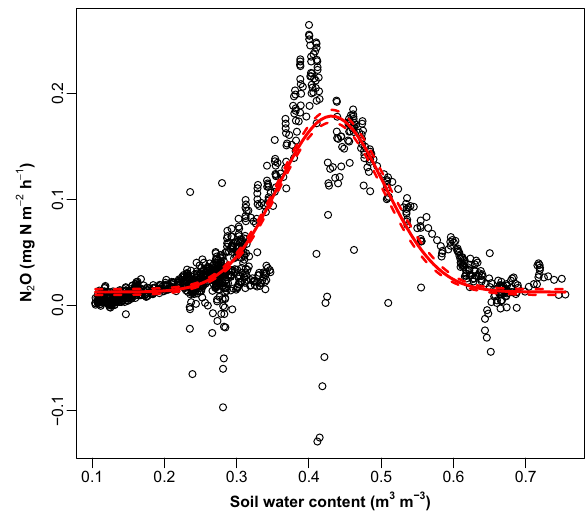
Fig. 5 Dynamics of soil water content (SWC) vs soil N 2 O fl ux (hourly average values) during the dry hot moment (2018-05- 01 … 2018-08-05). The curve is calculated after the Bragg equation with four parameters: Y = c + ( d − c ) × exp( − b )× ( X − e ) 2 , where b = 92.77, c = 0.0123, d = 0.1786, e = 0.4314 and X is SWC and Y is N 2 O fl ux ( R 2 = 0.74, p < 0.001, n = fi ne roots decreasing competition between roots and microorgan- isms for nitrate, the main substrate for N 2 O production 16 .